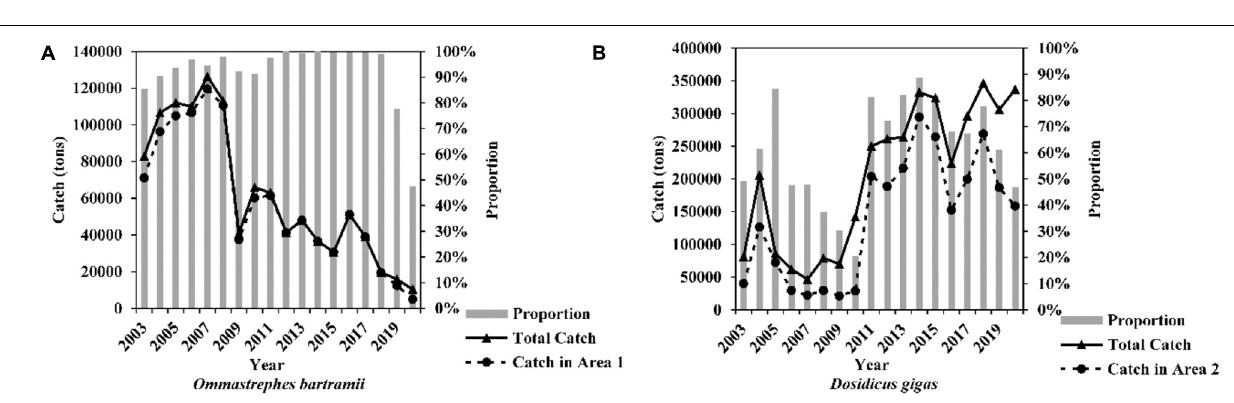
FIGURE 2 | Annual catch, the catch, and its proportion within Area 1 (for Ommastrephes bartramii , A ) and Area 2 (for Dosidicus gigas , B ) in 2003–2020 for China squid-jigging fleets (Area 1: the Chinese main fishing ground of O. bartramii , west water of 170 ◦ E. Area 2: the Chinese main fishing ground of D. gigas off Peru Exclusive Economic Zone waters (see Figure 1